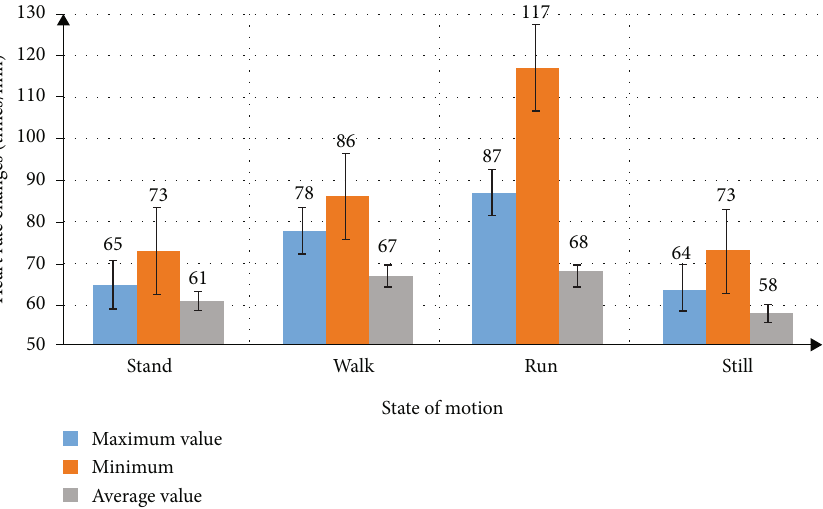
Figure 9: Heart rate changes in di ff erent